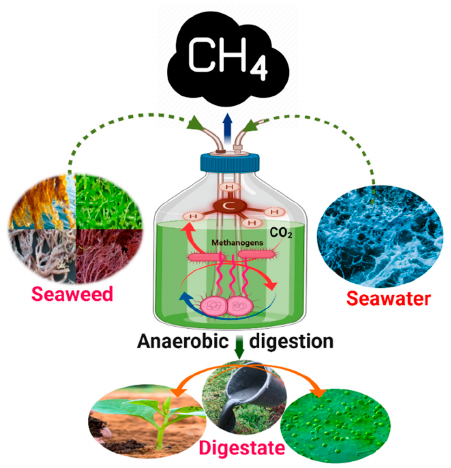
Table 1. Key points of some previous published papers on marine resources for biorefinery, com- pared to current review articles.